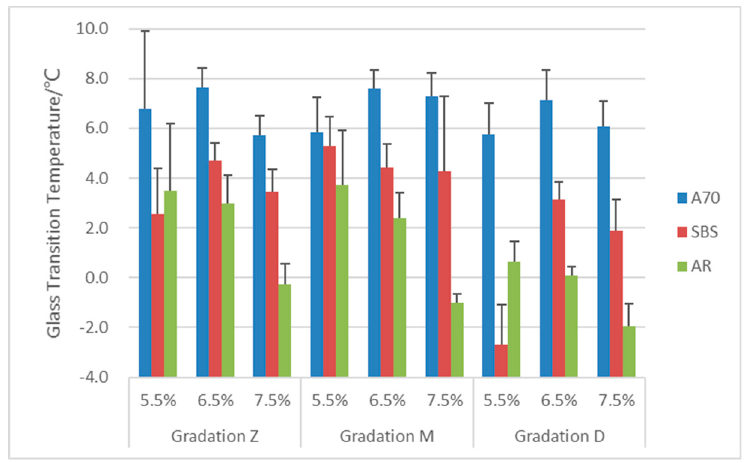
Figure 8. Tg of asphalt mixtures.